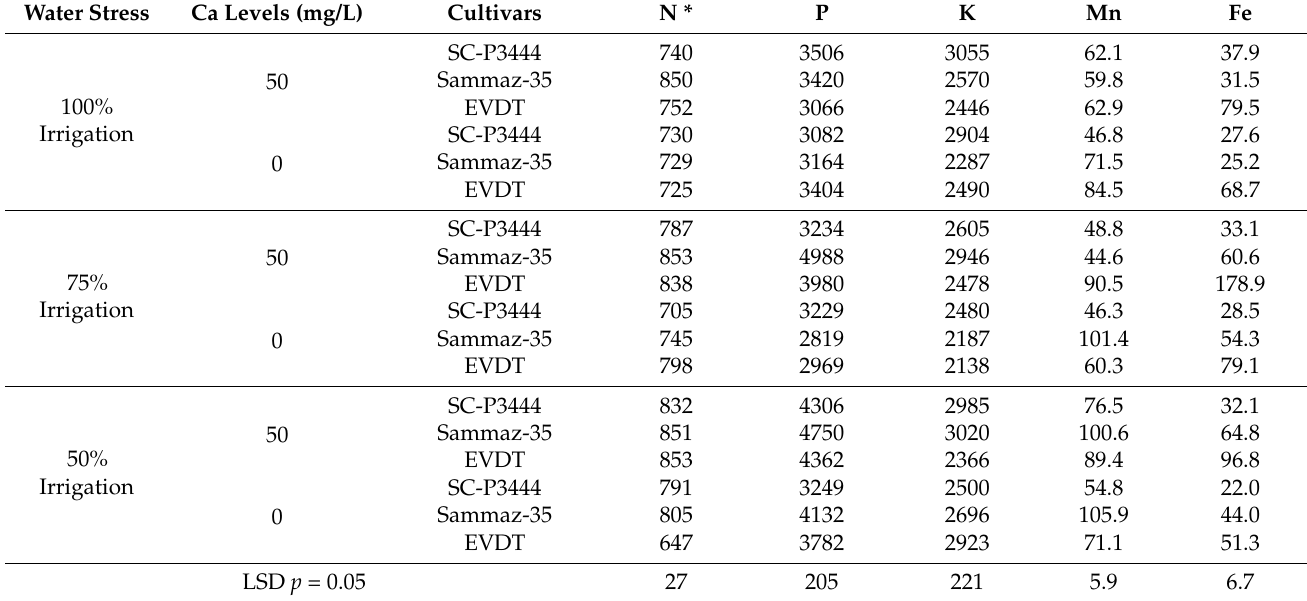
Table 8. Ion contents (N, P, K, Mn, and Fe mg/kg) as affected by water regimes, calcium level and maize cultivars. Water